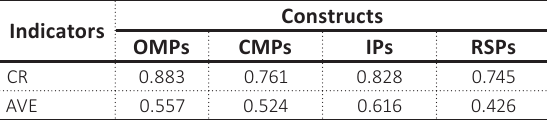
Table 2. Validity measures